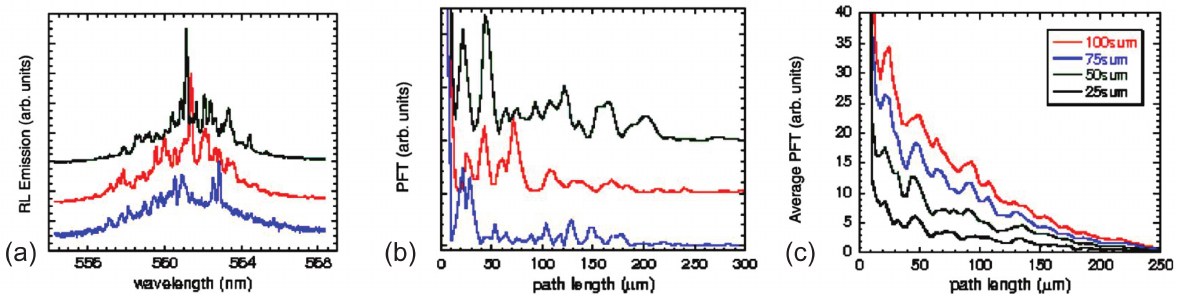
Figure 3. Averaged PFT of RLs in methanol colloid of 1 mM R6G and 8.6 × 10 9 cm − 3 TiO 2 ( l t ≈ 12 µm). ( a ) Three RL spectra generated by single individual excitation pulses. ( b ) The PFT of RL spectra shown in ( a ). ( c ) Averaged PFT of RL spectra over multiple excitation. The distinct Fourier harmonics are resolved. Adapted from Ref. [25] with permission from American Physical